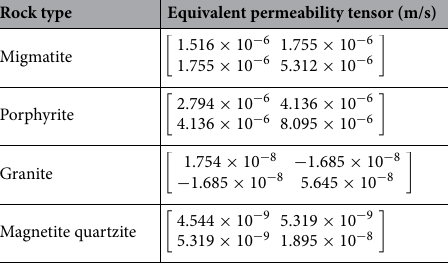
Table 4. Equivalent permeability tensor of rock mass.